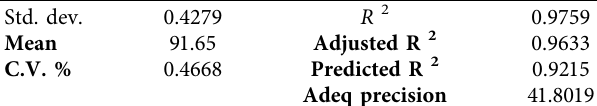
Table 4: Model adequacy measure.